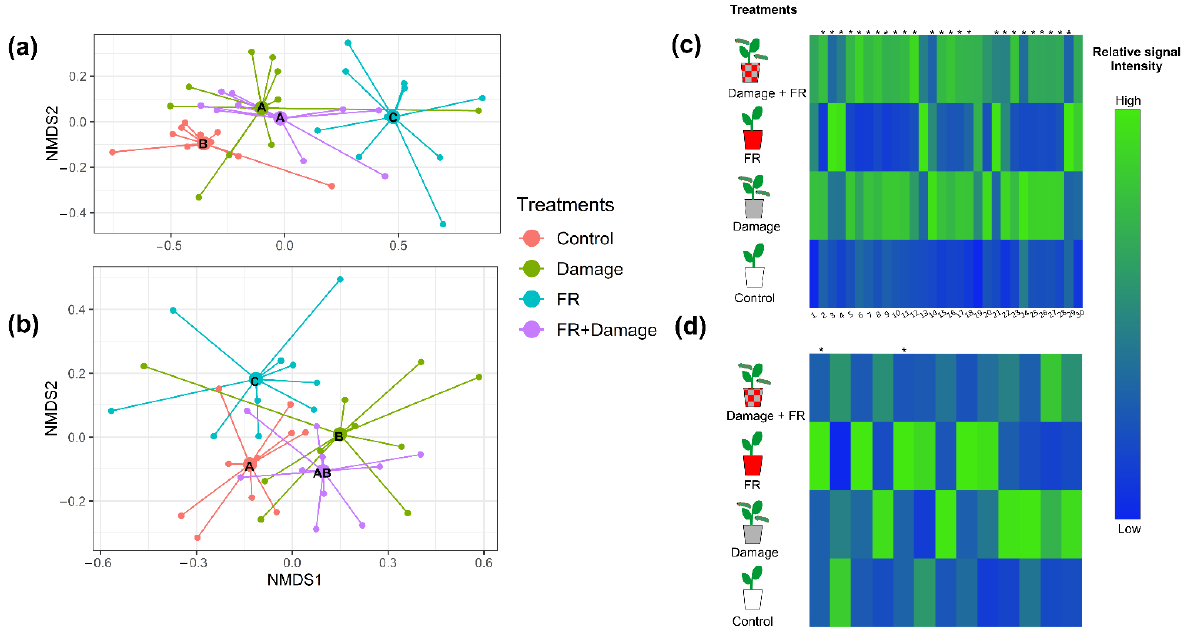
Figure 3. Plant secondary metabolite production in response to supplemented far-red (FR) light exposure and herbivore damage. Non-metric multidimensional scaling (NMDS) of ( a ) volatile organic compound emissions (stress value = 0.115) and ( b ) non-volatile secondary metabolite production (stress value = 0.163) of Solidago altissima plants, growing under reduced red:far red light ratios (FR), with damage by larvae of Spodoptera frugiperda (Damage), the combination of FR supplementation and damage (FR + Damage), or under control light (control) conditions. Different letters in the NMDS centroids indicate significant differences based on a post hoc test of a PERMANOVA. Heat map of ( c ) the emission of volatile organic compounds (VOCs) with tentative identification (1. Cymene, 2. Dimethyl-1,3,7-nonatriene, 3. (3 Z )-Hexenyl acetate, 4. 1,3,8 -Menthatriene, 5. Unknown 1, 6. Unknown 2, 7. Unknown 3, 8. p-Copaene, 9. β -Bourbonene, 10. α -Cubebene, 11. Linalyl isobutyrate, 12. Unknown 4, 13. Bornyl acetate, 14. 1,5-Cyclodecadiene, 15. β -Caryophyllene, 16. Unknown 5, 17. Unknown Sesquiterpene 1, 18. α -Humulene, 19. Unknown Sesquiterpene 2, 20. γ -Muurolene 21. Unknown sesquiterpene 3, 22. Methyl salicylate, 23. Unknown 6, 24. Unknown aliphatic compound, 25. Unknown 7, 26. Unknown 8, 27. Unknown 9, 28. α -Phellandrene, 29. β -pinene, and 30. Limonene), and ( d ) the production of non-volatile compounds (1. Unknown 10, 2. Diterpene 1, 3. Coumaric acid 1, 4. Coumaric acid 2, 5. Chlorogenic acid, 6. Coumaric acid 3, 7. Flavonoid 1, 8. Diterpene 2, 9. Diterpene 3, 10. Diterpene 4, 11. Diterpene 5, 12. Diterpene 6, and 13. Diterpene 7) whose production is significantly varying with treatment ( p < 0.05). The different treatments include untreated controls, plants exposed to increased FR radiation (FR), plants damaged by S. frugiperda caterpillars (Damage), and plants that received both treatments (FR + Damage). The heat maps include those compounds that explain most of the variation between treatments based on Random Forest Analyses. Different shades of color represent different signal intensity based on individual ANOVAs. * Indicate significance ( p < 0.05) after false discovery rate